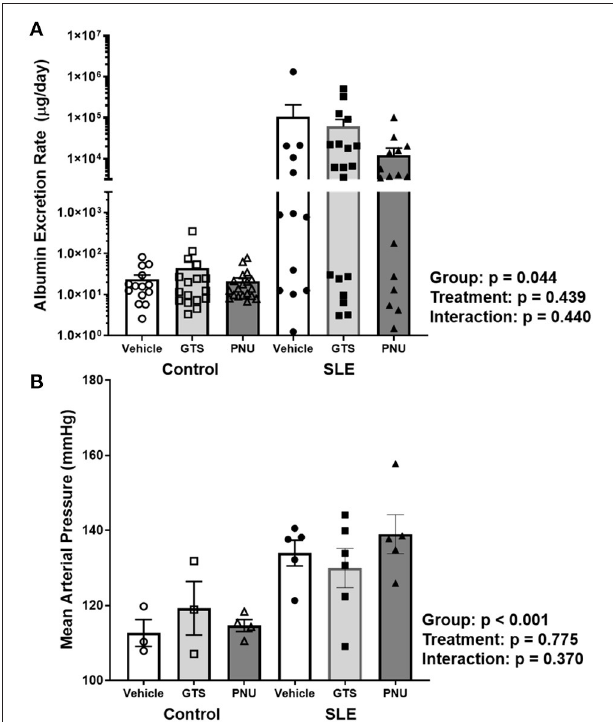
FIGURE 3 | (A) Albumin excretion rate (mg/day) in control and SLE mice treated with either vehicle, GTS-21, or PNU-120596. Neither GTS-21 nor PNU-120596 had a significant effect on albumin excretion rate in control or SLE mice ( n = 13–19 per/group) Data were analyzed using a two-way ANOVA and the results of this analysis are listed on the graph. Note: the y-axis is presented as a log scale. (B) Mean arterial pressure (mmHg) in control and SLE mice treated with either vehicle, GTS-21, or PNU-120596. Neither GTS-21 nor PNU-120596 had a significant effect on mean arterial pressure in conscious and freely moving control or SLE mice ( n = 3–6 per group). Data were analyzed using a two-way ANOVA and the results of this analysis are listed on the